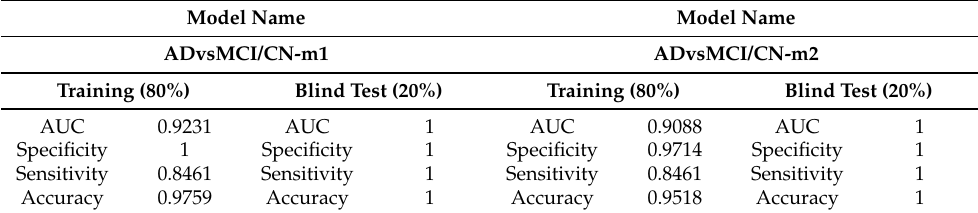
Table 6. Training metrics and blind test validation of SVM